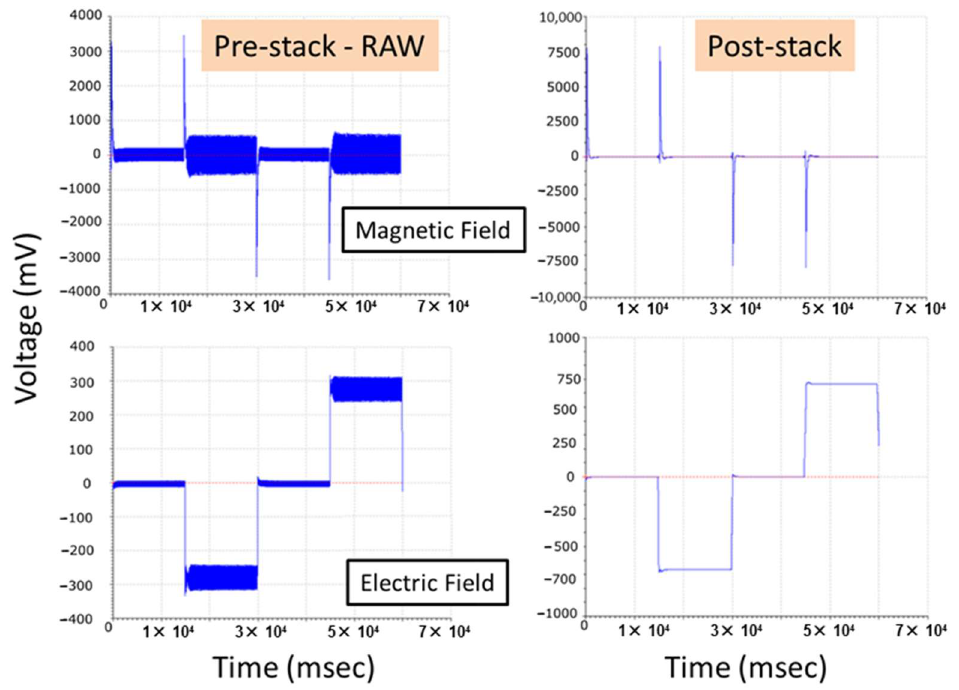
Figure 8. Raw ( left column ) versus post-stacked ( right column ) data displays for electric and magnetic fields measurements.